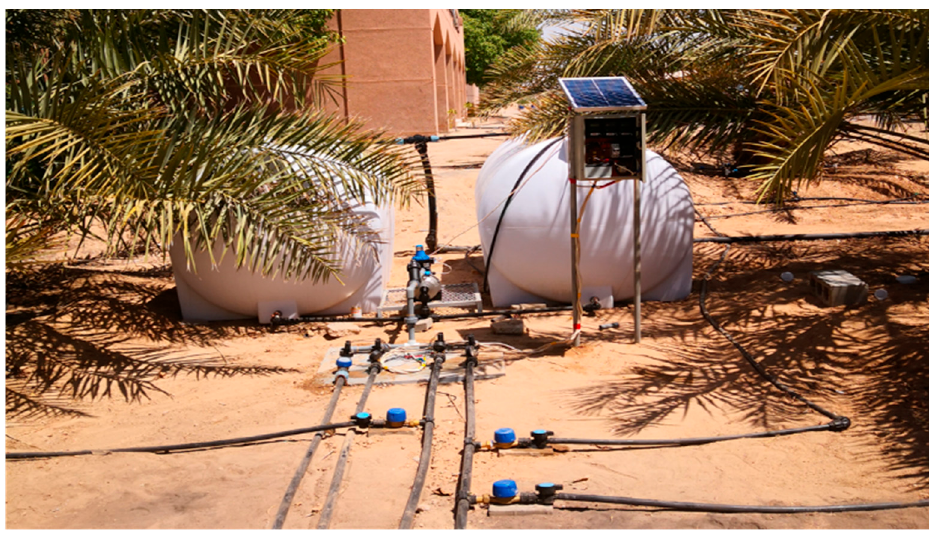
Figure 1. Experimental setup of the irrigation systems.